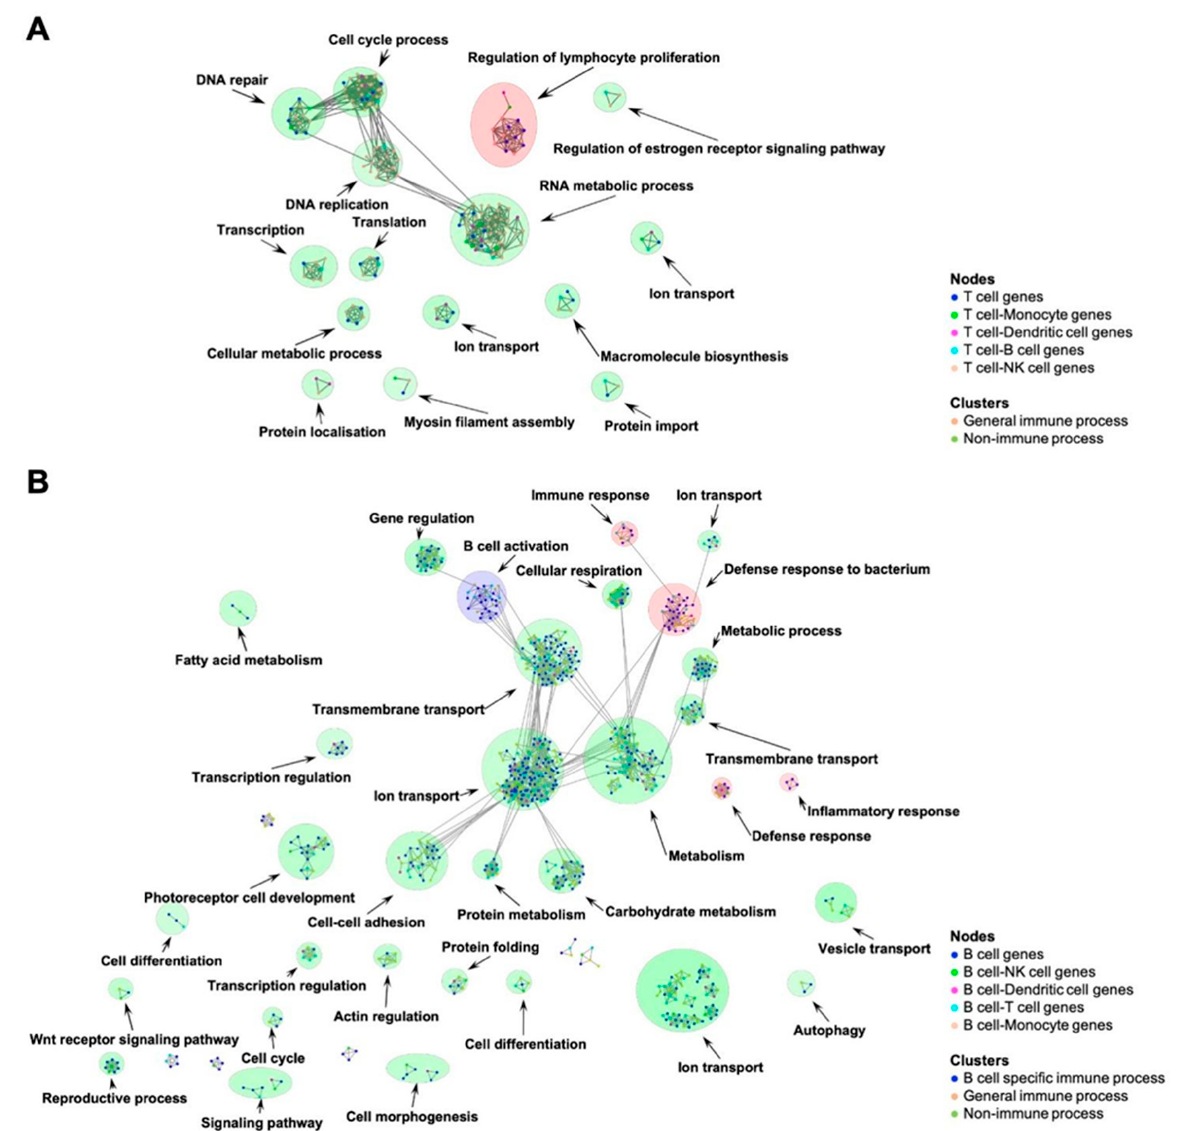
Figure 2. T cell and B cell focus networks. Node colour shows the overlap of genes with other cell types in IMMUNETS and genes present in a single network are shown in blue. Edges were significant according to NetNC-FTI analysis (methods). The coloured circles around clusters indicate broad annotation classes where significant GO terms were identified; red corresponds to general immune GO annotations, blue represents cell-type specific immune processes and green shows clusters with annotation terms that are not immune-specific. ( A ) Most clusters in the T cell focus network represent processes important for cell proliferation. A ‘regulation of lymphocyte proliferation’ cluster (red) contains multiple T cell genes (IL17A, CD5, IL13, IL5, IL2, CD8A, CD28). ( B ) The B cell focus network has one cell-specific immune cluster (blue) ‘B cell activation’, including CD79A, CD79B and CD19. The four clusters annotated with general immune processes (red), such as ‘inflammatory response’, contain important B cell genes for example IL22, IL10RB, IL20RA, and IL22RA1. Cytoscape sessions for the IMMUNETS focus networks are available in Supplementary Data File S1.